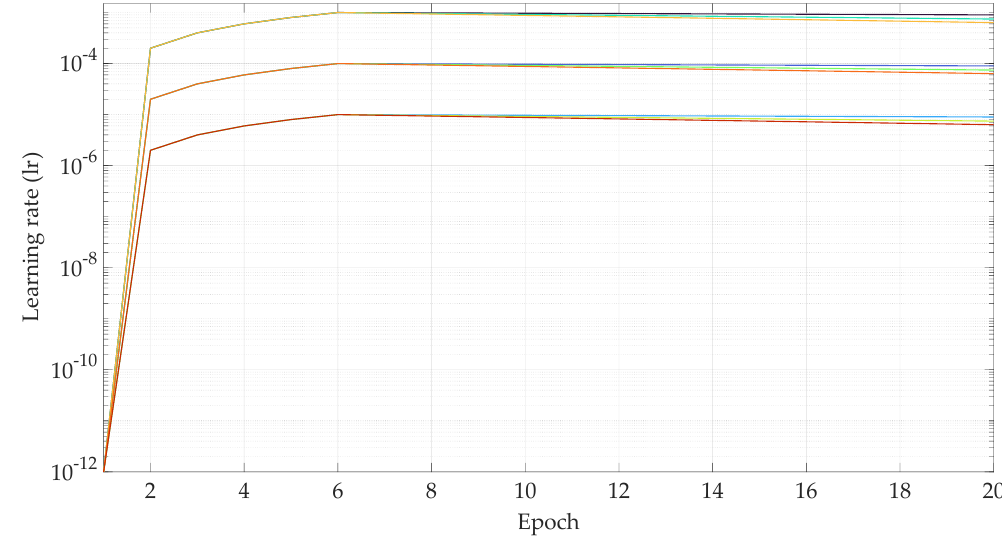
Figure 12. Learning rate with respect of the training epoch for the hyper-parameter optimization. [ lr max = 10 − 3 ,drop = 1.1 ] , [ lr max = 10 − 4 ,drop = 1.1 ] , [ lr max = 10 − 5 ,drop = 1.1 ] , [ lr max = 10 − 3 ,drop = 1.3 ] , [ lr max = 10 − 4 ,drop = 1.3 ] , [ lr max = 10 − 5 ,drop = 1.3 ] , [ lr max = 10 − 3 ,drop = 1.5 ] , [ lr max = 10 − 4 ,drop = 1.5 ] , and [ lr max = 10 − 5 ,drop = 1.5 ]